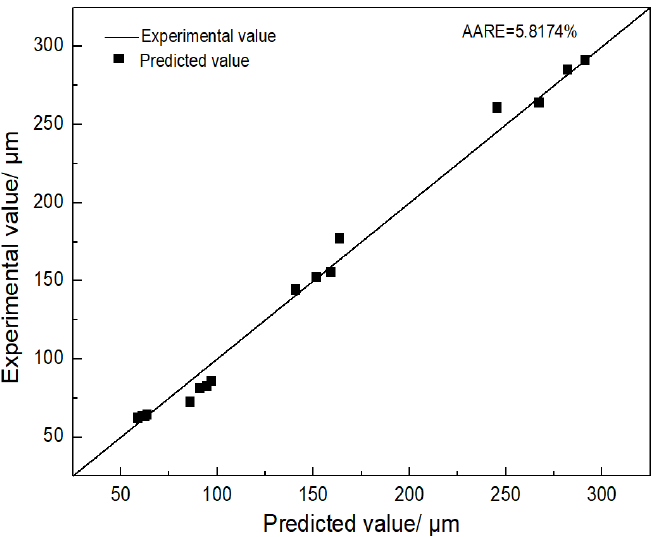
Figure 8. The comparison of the prediction results of grain size with experimental results.